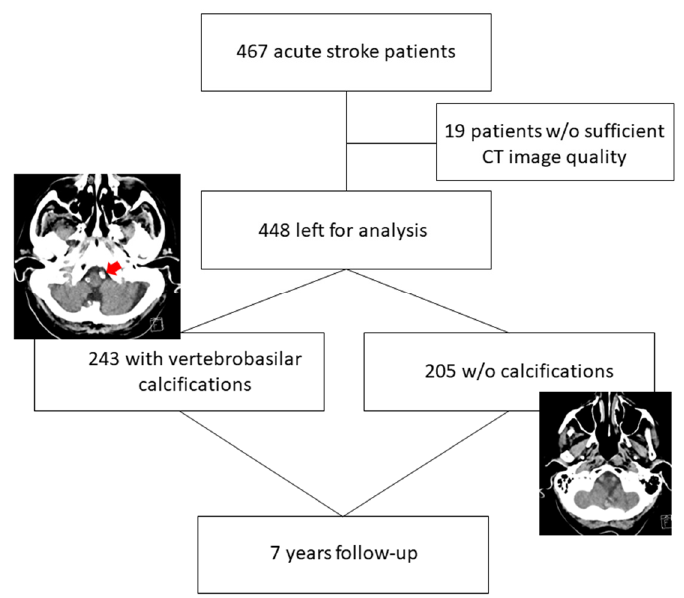
Figure 1. Patient flow diagram during the 7-year study period. Left image: The red arrow depicts calcifications on nonenhanced brain computer tomography (NECT) in left (and right–not labelled) vertebral artery in an 89-year-old man with stroke (representative for the vertebrobasilar artery calcification (VBC) group). Right image: no calcification in vertebrobasilar vessels in an 88-year-old woman with stroke (control group, nonVBC).